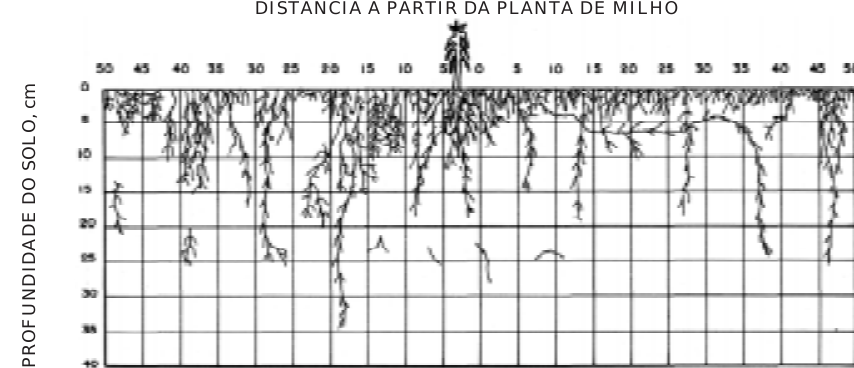
Figura 1. Distribuição radicular do milho em solo sob plantio direto não pastejado.